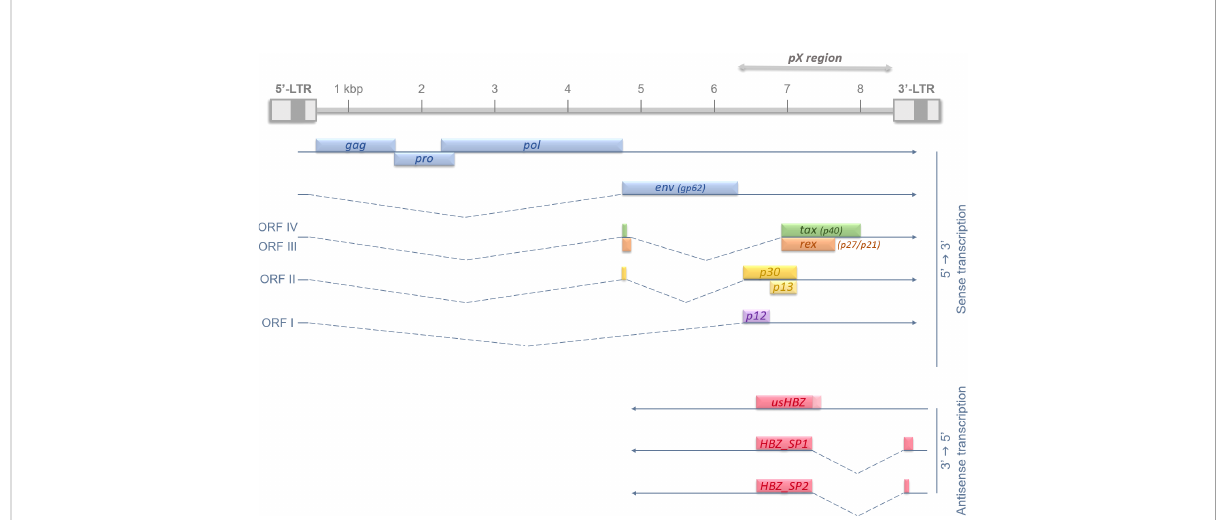
FIGURE 1 Recapitulative diagram of HTLV-1 proviral genome, Open Reading Frames (ORFs), and splicing-regulated genes. HTLV-1 genome is 9 kb long and fl anked on each side by 5 ’ and 3 ’ Long Terminal Repeats (LTRs). HTLV-1 LTRs are approximately 750 bp in length and are segmented in U3, R and U5 regions (in order). U3 region usually contains enhancer and promoter sequences which drive viral transcription; and R domain encodes the 5 ′ capping sequences (5 ′ cap) and the polyadenylation (pA) signal. The structural genes gag, pro, pol and env are encoded in the 5 ’ part of the provirus, and regulatory and auxiliary proteins are encoded in the pX region, at the 3 ’ side. The transcription initiates in the promoter- bearing 5 ’ -LTR in 5 ’ → 3 ’ for all viral genes, except for the antisense transcripts of hbz. hbz is encoded by the proviral complementary strand and its transcription, initiated in the 3 ’ -LTR, occurs in an antisense fashion (3 ’ → 5 ’ ). The different Open Reading Frames (ORFs) are indicated in roman numbers and splicing events are shown by dotted